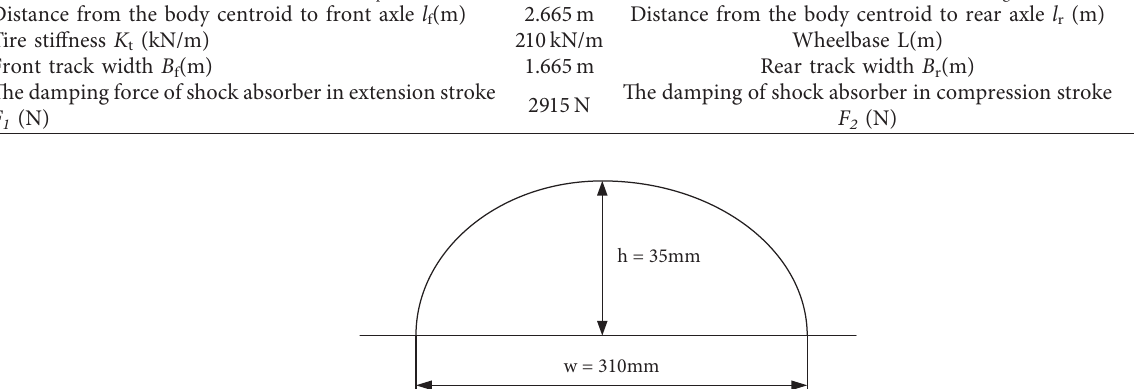
Figure 8: Transect of the speed hump.